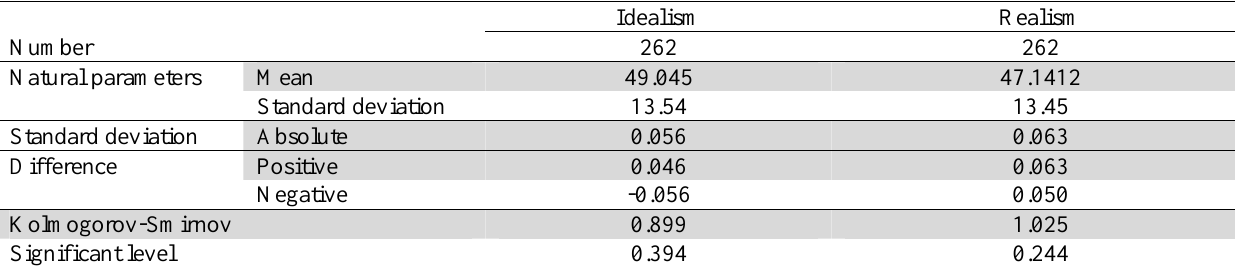
Results of data normality